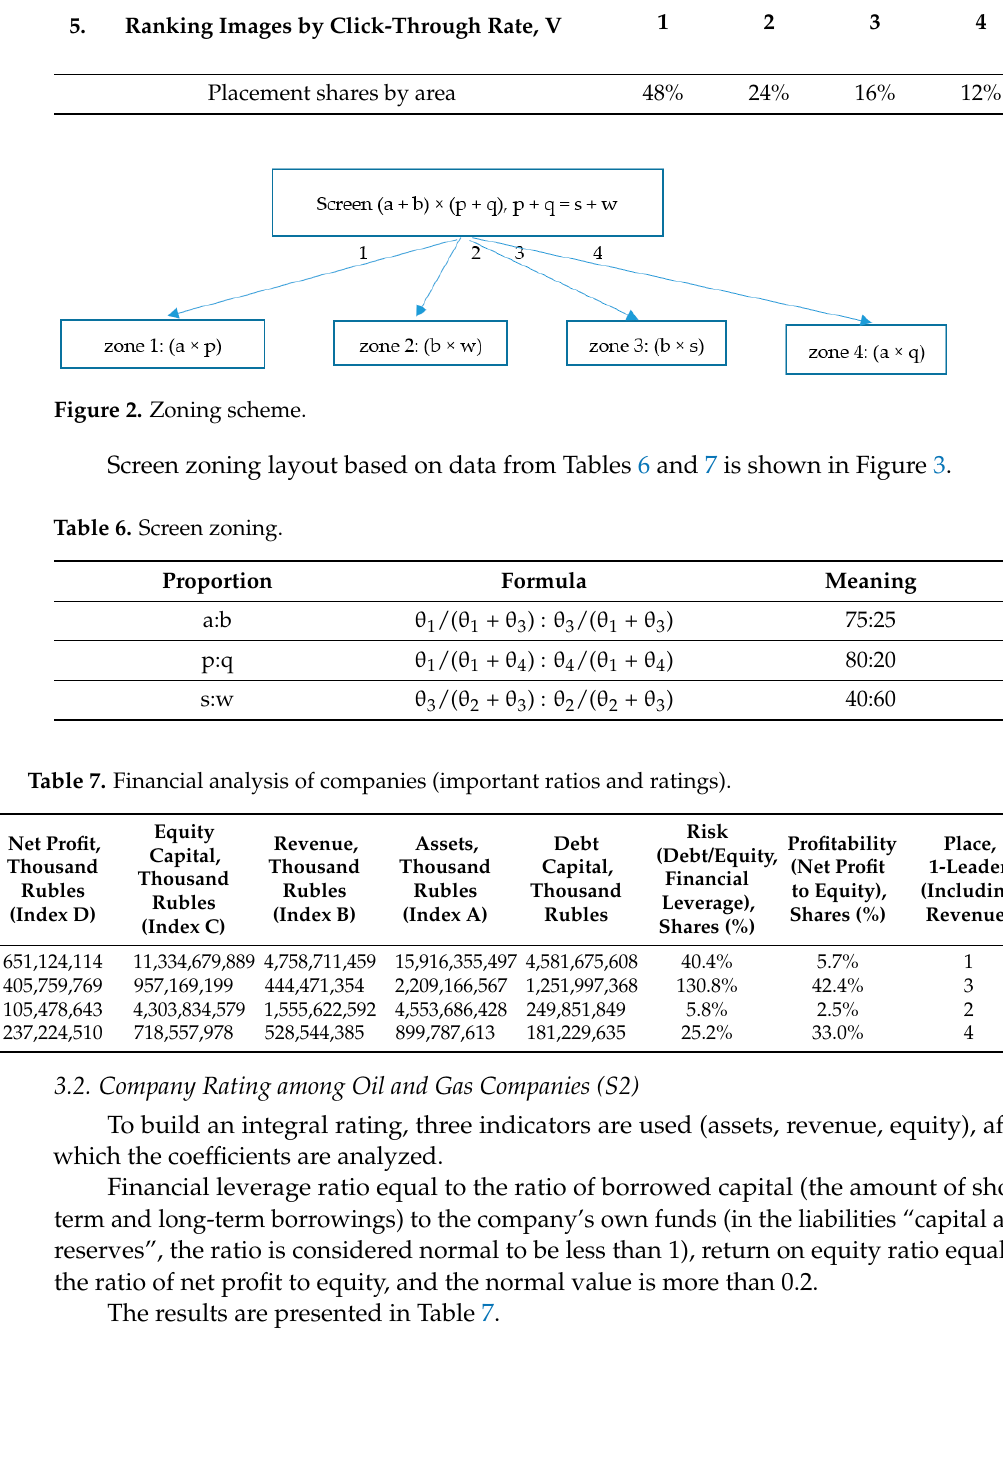
Table 5. Data for analysis.